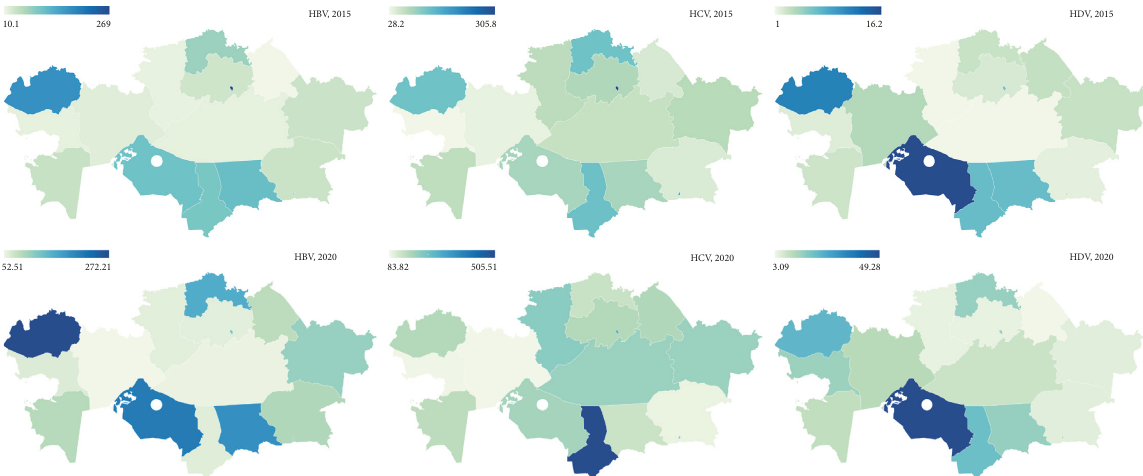
Figure 2: Prevalence of viral hepatitis B, D, and C in 2015 and 2020 on the territory of the Republic of